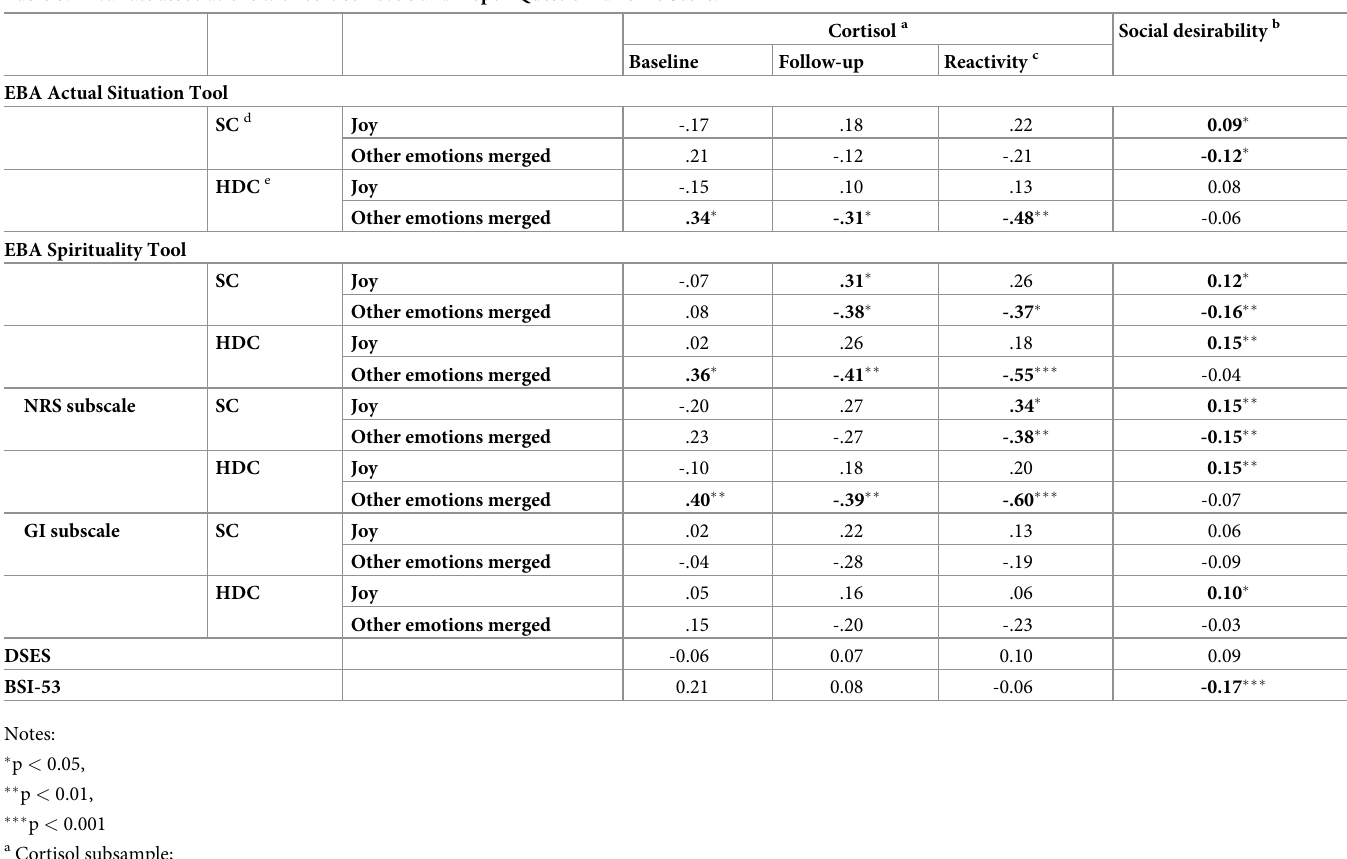
Table 8. Bivariate associations with cortisol levels and Dopen Questionnaire Lie